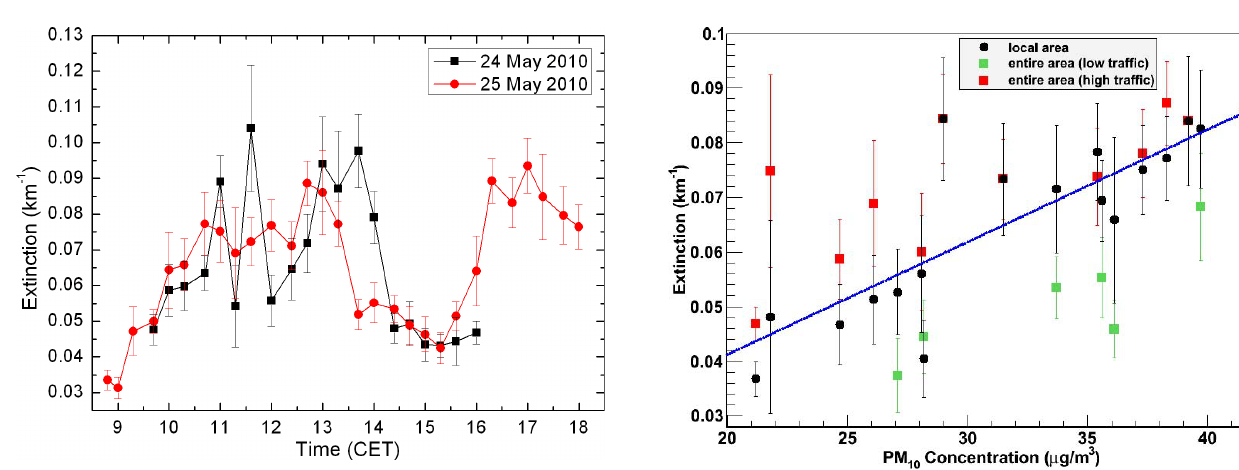
Fig. 8. The correlation between the LIDAR-derived extinction and the PM 10 concentration. The extinction for the entire dataset (black points) in a localized area with a radius R ≤ 300m directly above the ground-based measurement site was found to be related to the PM 10 concentration with a correlation coefficient of 0.84 and a slope of 0.002 ± 0.00007m 3 km − 1 µg − 1 (blue line). Red points (correlation coefficient 0.72) represent the extinction values aver- aged over the entire scanning area for intervals of high traffic and green points (correlation coefficient 0.86) for periods of low traffic. In the fits, aerosol extinction was constrained to zero for the limit case, when PM 10 concentration was